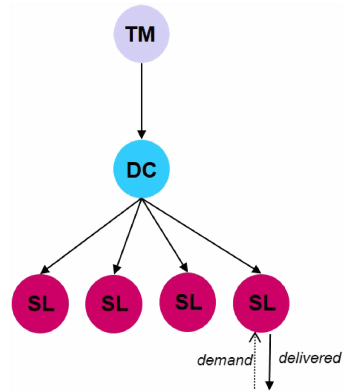
Figure 9. Network used to evaluate centralized and distributed configurations for all demand